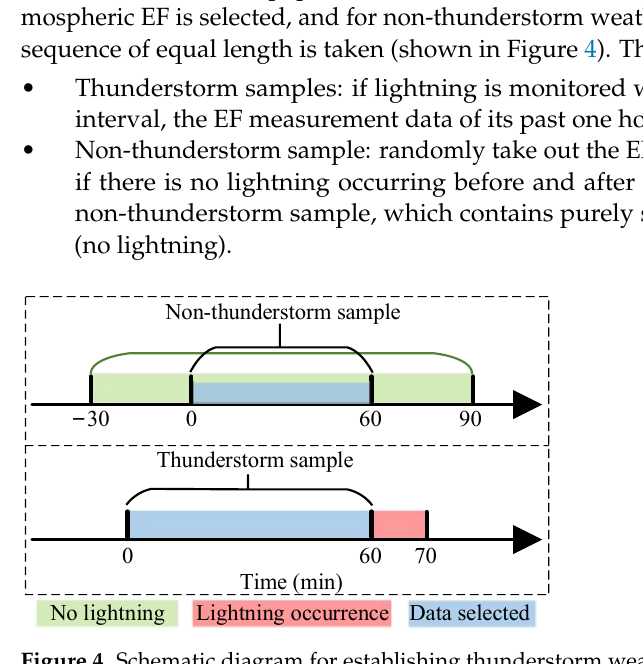
Figure 4. Schematic diagram for establishing thunderstorm weather samples and non-thunderstorm weather